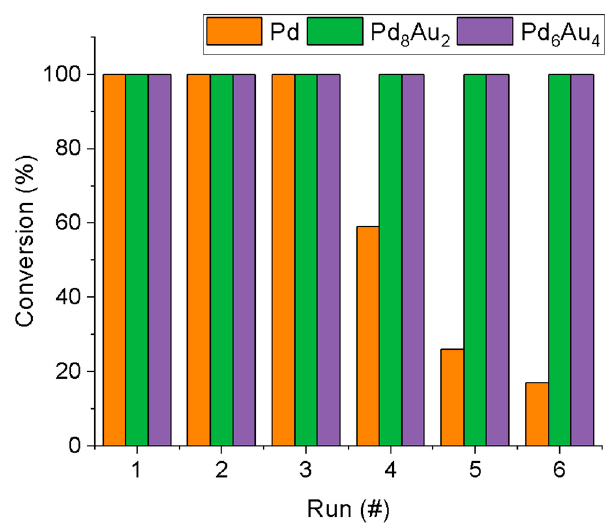
Figure 8. MA conversion after 60 min during recycling tests. #: progressive number of recycle run.